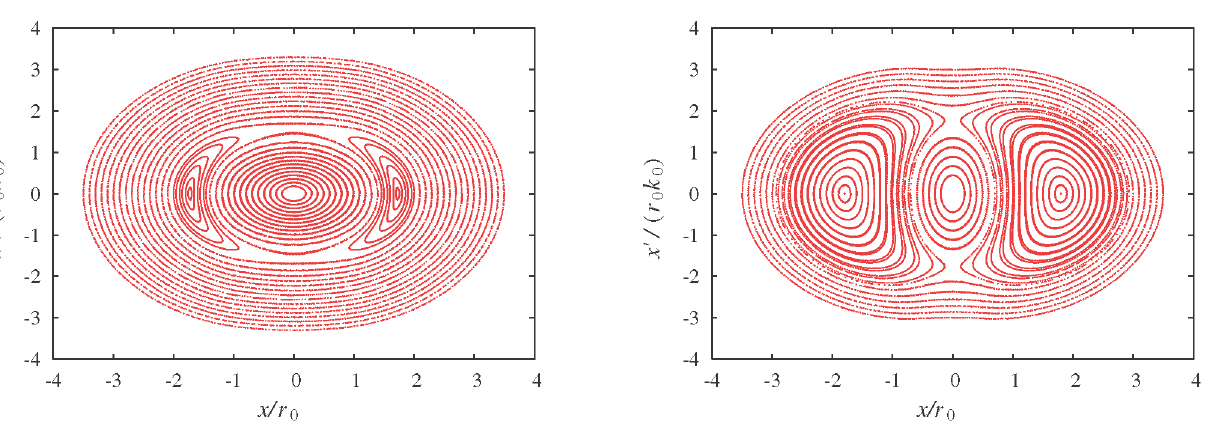
FIG. 3. (Color) Stroboscopic plot for (cid:16) (cid:3) 0 : 6 , 0 : 2 (cid:11) x (cid:4) 0 (cid:5) =r 3 : 5 , and (cid:18) (cid:3) 0 : 8